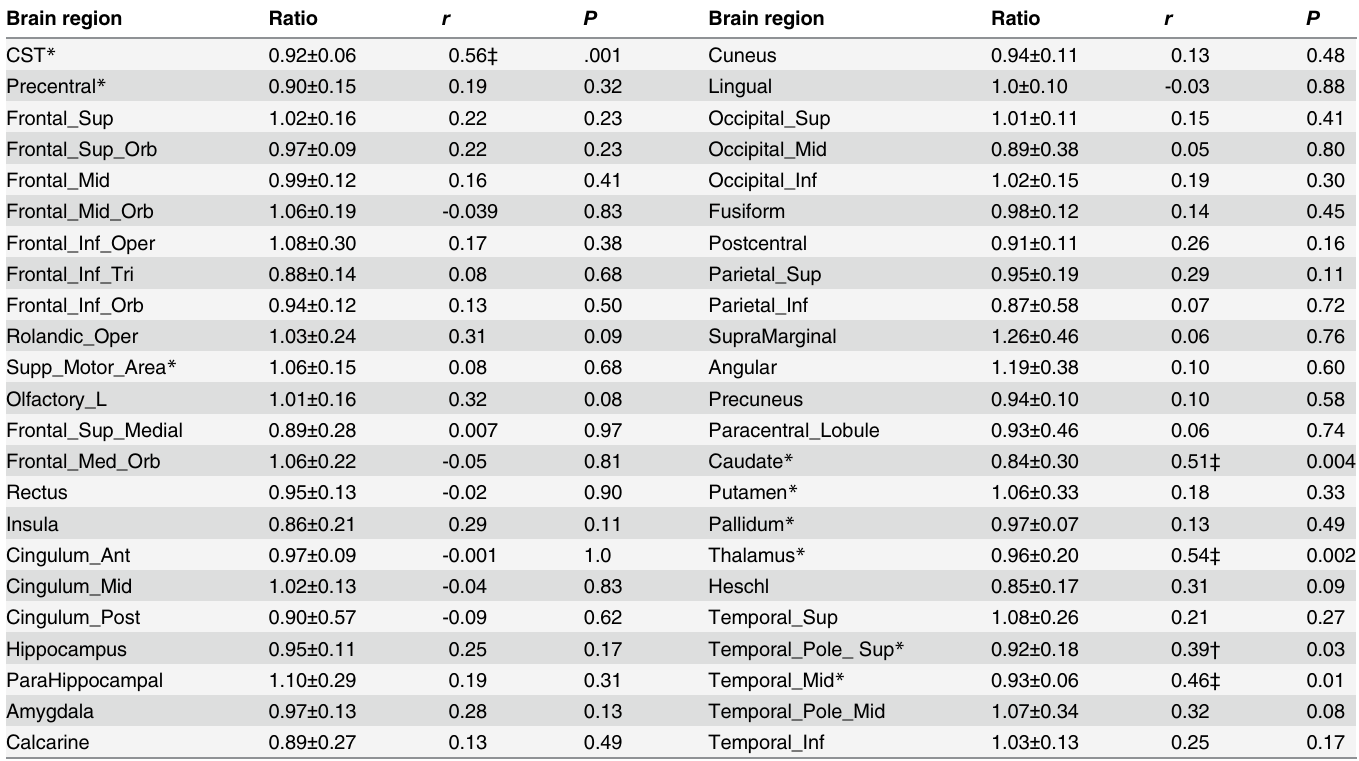
Table 3. Relationships between CST ratio , VOI ratio, and UE-FM (n =